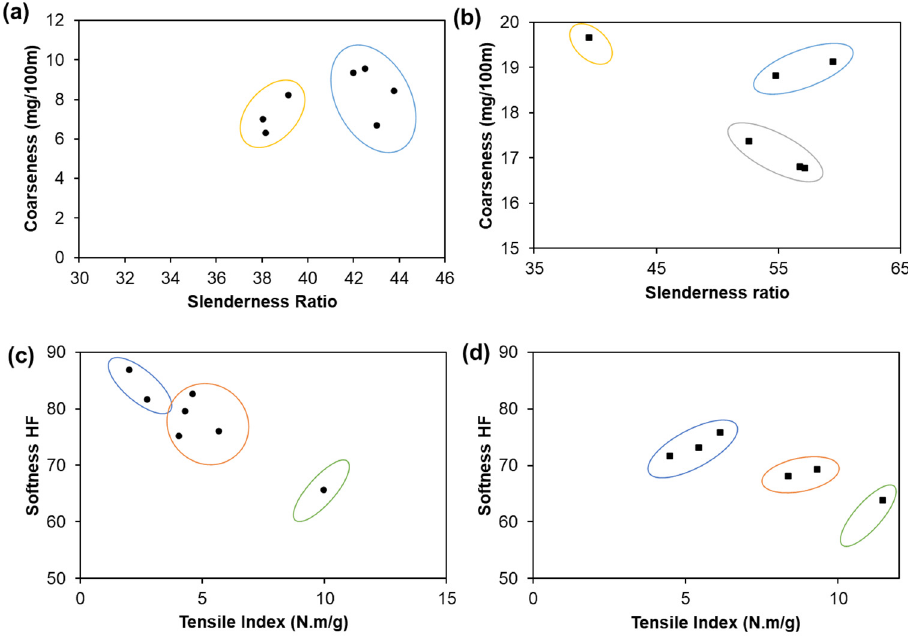
Figure 1. Coarseness as a function of slenderness ratio of hardwood ( a ) and softwood ( b ) fiber pulps, as well as softness HF as a function of tensile index properties of hardwood ( c ) and softwood ( d ) fiber